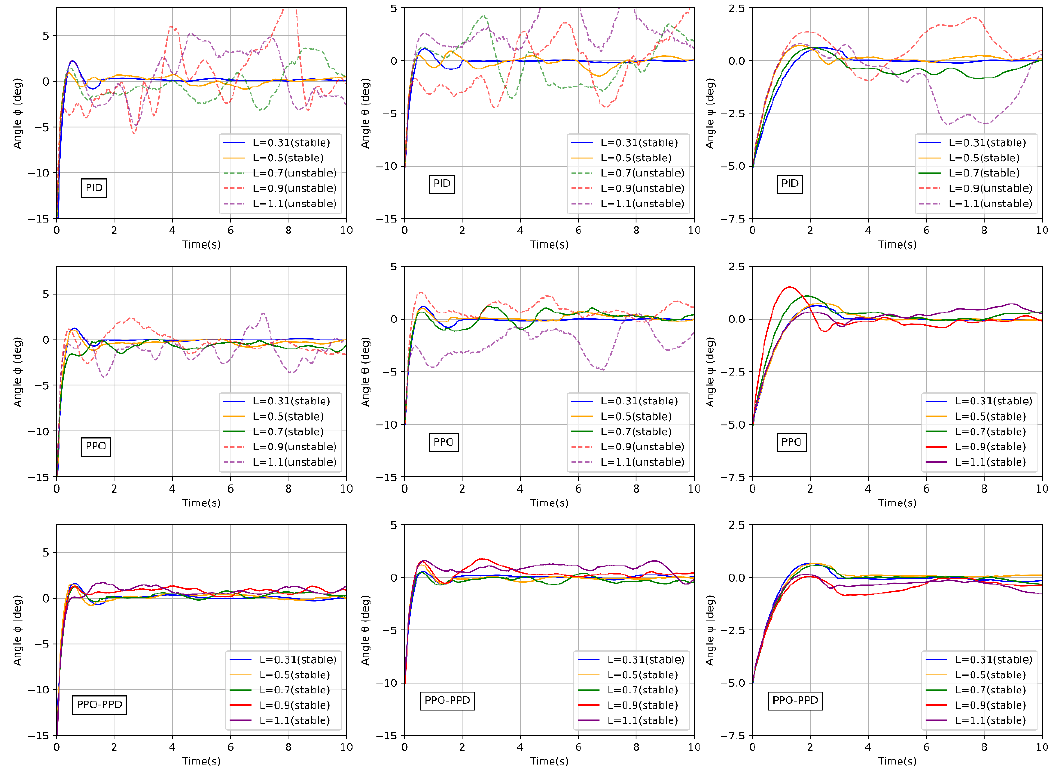
Figure 13. Attitude comparison among PID, PPO and PPO-PPD controller in different sizes.